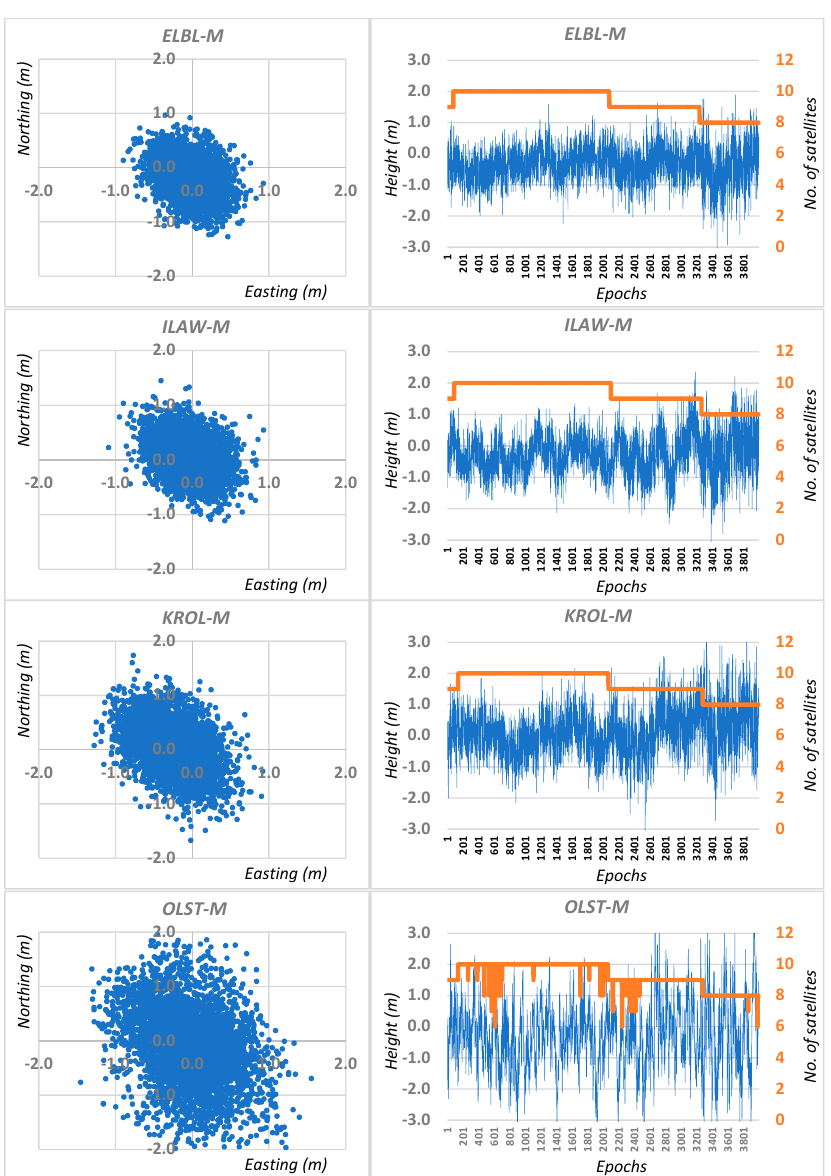
Figure 2. Real errors of single epoch traditional DGPS positioning based on least squares solutions for session I.